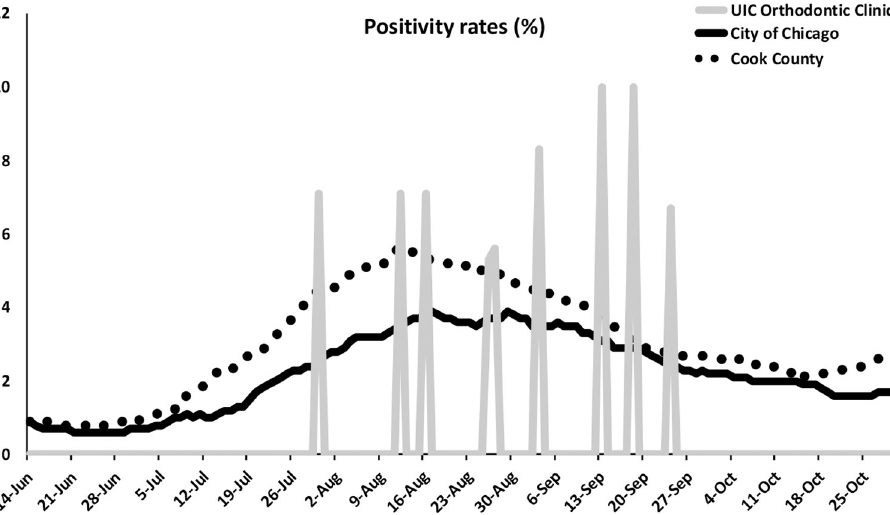
Fig 5. Correlations among the SARS-CoV-2 positivity rates of the orthodontic clinic, University of Illinois Chicago, Chicago and Cook County, Illinois. There was no correlation between the positivity of SARS-CoV-2 infection at the orthodontic clinic and the city of Chicago and Cook County, IL. There was a high correlation between the positivity rates of the City of Chicago and Cook County. The lag-zero correlation was 0.943, and the direction of the correlations was